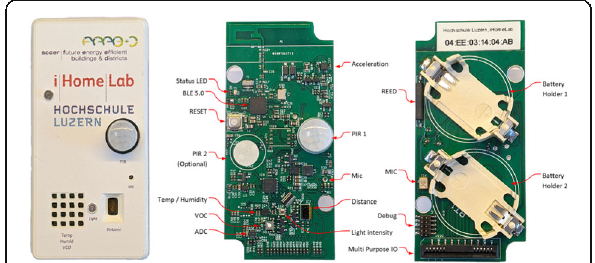
Fig. 1 (abstract P4). Developed sensor platform. Front PCB (center) and backside (right) show the location of the most important sensors and controllers. For adequate protection of the sensors, a custom 3D printed case (left) was